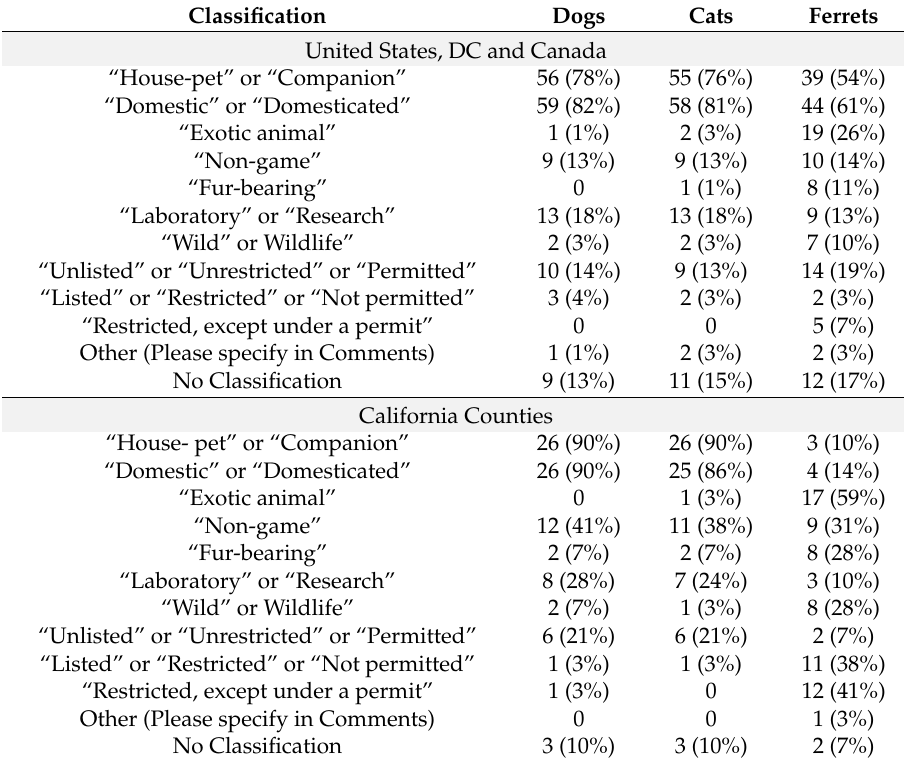
Table 5. Terms used by agencies to classify dogs, cats,